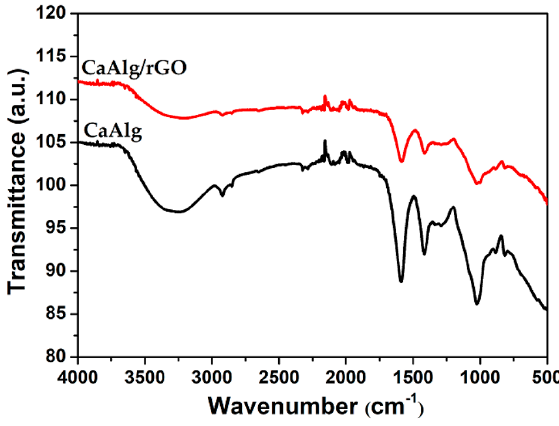
Figure 1. Fourier transform infrared spectroscopy (FT-IR) spectra of the CaAlg and CaAlg/rGO materials.